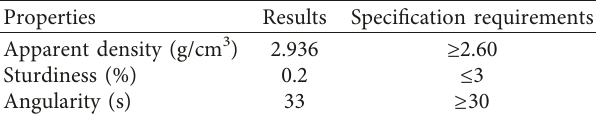
Table 3: Properties of fine aggregates.